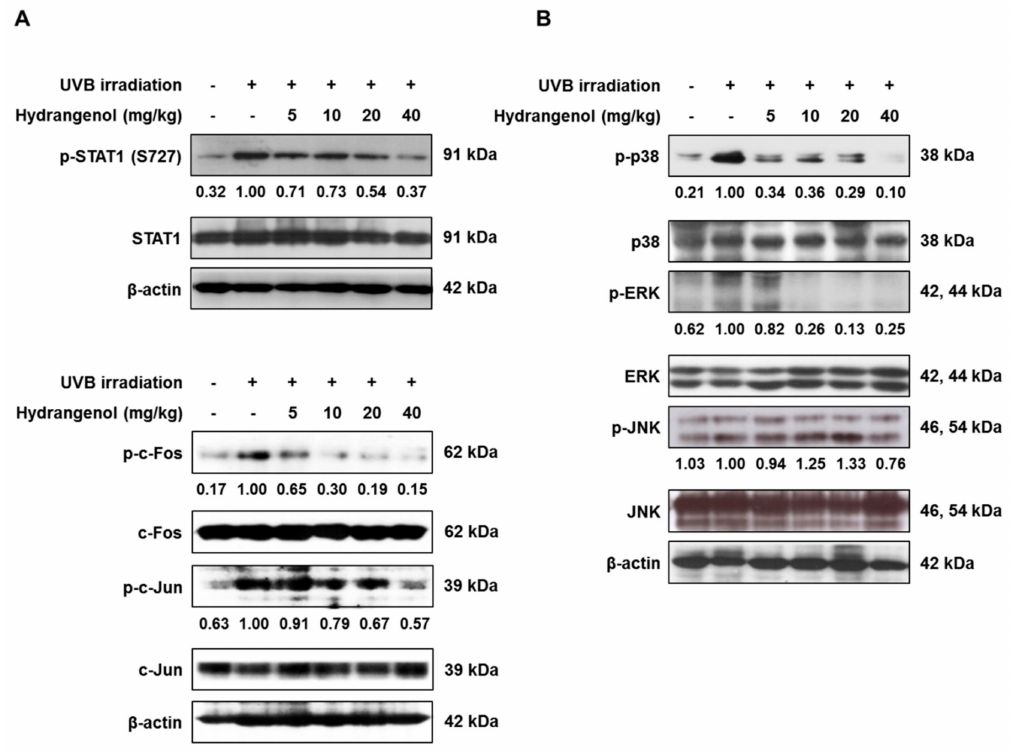
Figure 7. E ff ects of oral administration of hydrangenol on STAT1, AP-1, and the mitogen-activated protein kinase (MAPK) signaling pathway in UVB-irradiated hairless mice. HR-1 hairless mice were administered hydrangenol (5, 10, 20, or 40 mg / kg) daily for 7 weeks of exposure to UVB. Total proteins were extracted from dorsal skin tissues. The phosphorylation and expression of target proteins were estimated using Western blotting using specific p-STAT1 (S727), p-c-Fos, p-c-Jun, p-p38, phospho-extracellular signal-regulated kinase (p-ERK), and phospho-c-Jun N-terminal kinase (p-JNK) antibodies. The internal control was a β -actin protein. Representative blots of ( A ) STAT1, AP-1, and ( B ) MAPK signaling proteins. Each band is representative of three